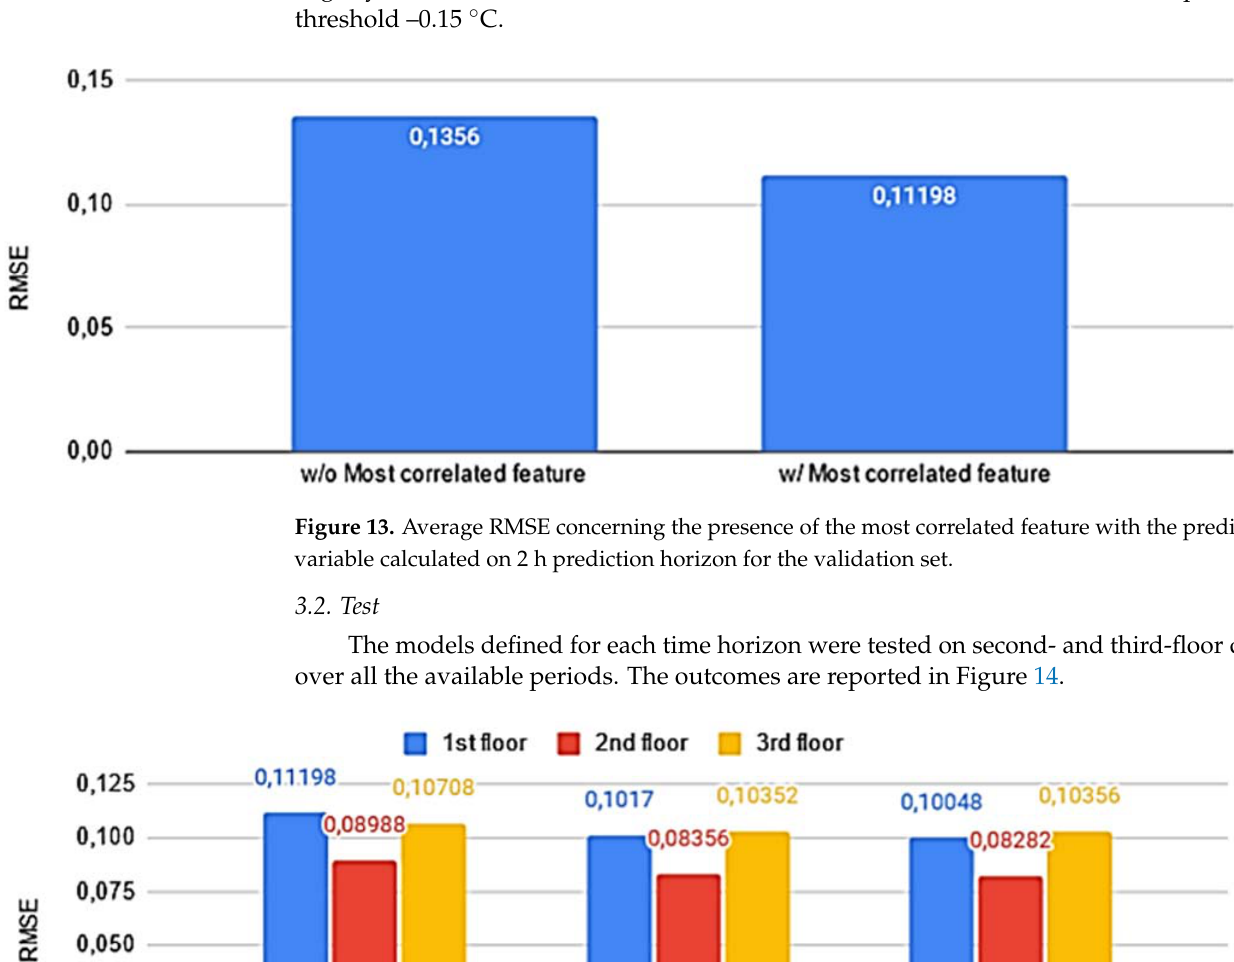
Figure 12. Average RMSE trend concerning prediction horizon by model structure for the validation set.